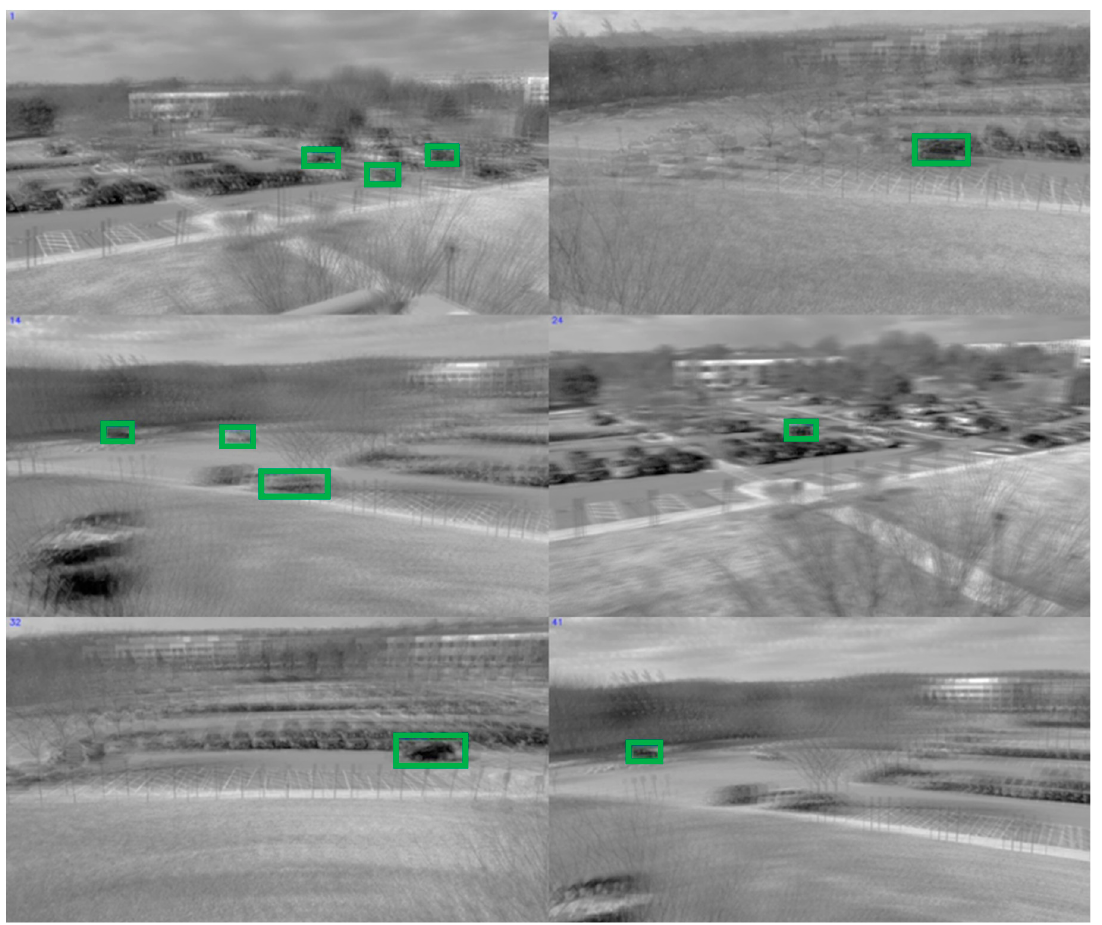
Figure A1. IMG429 with 0 percent missing, tiled image results. Bounding box detections outlined in green.